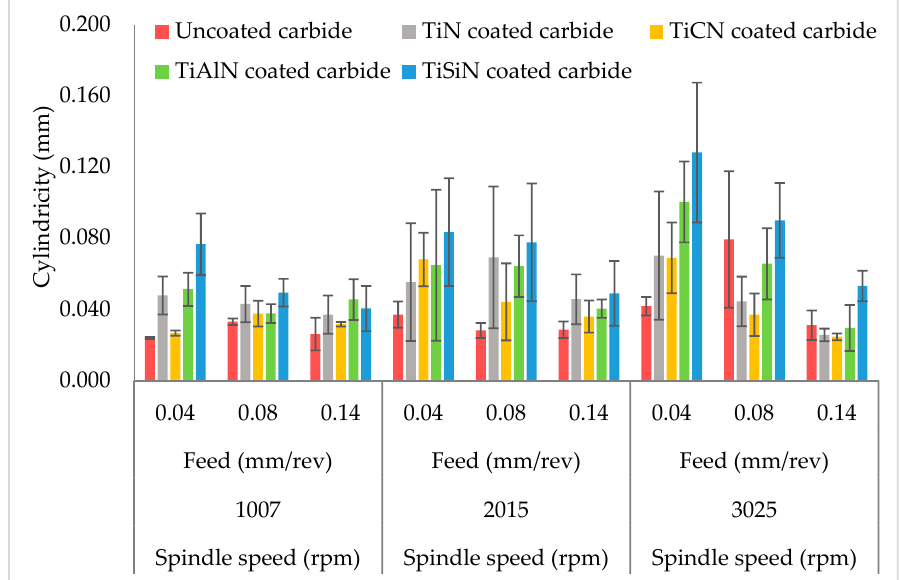
Figure 4. Average cylindricity error .